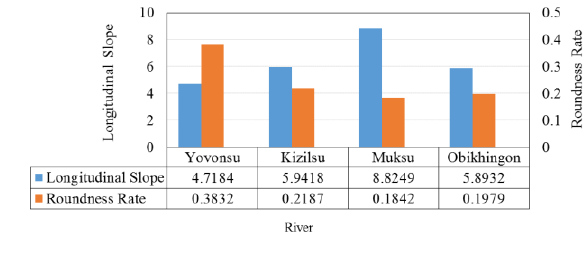
Figure 7. The landform development indices